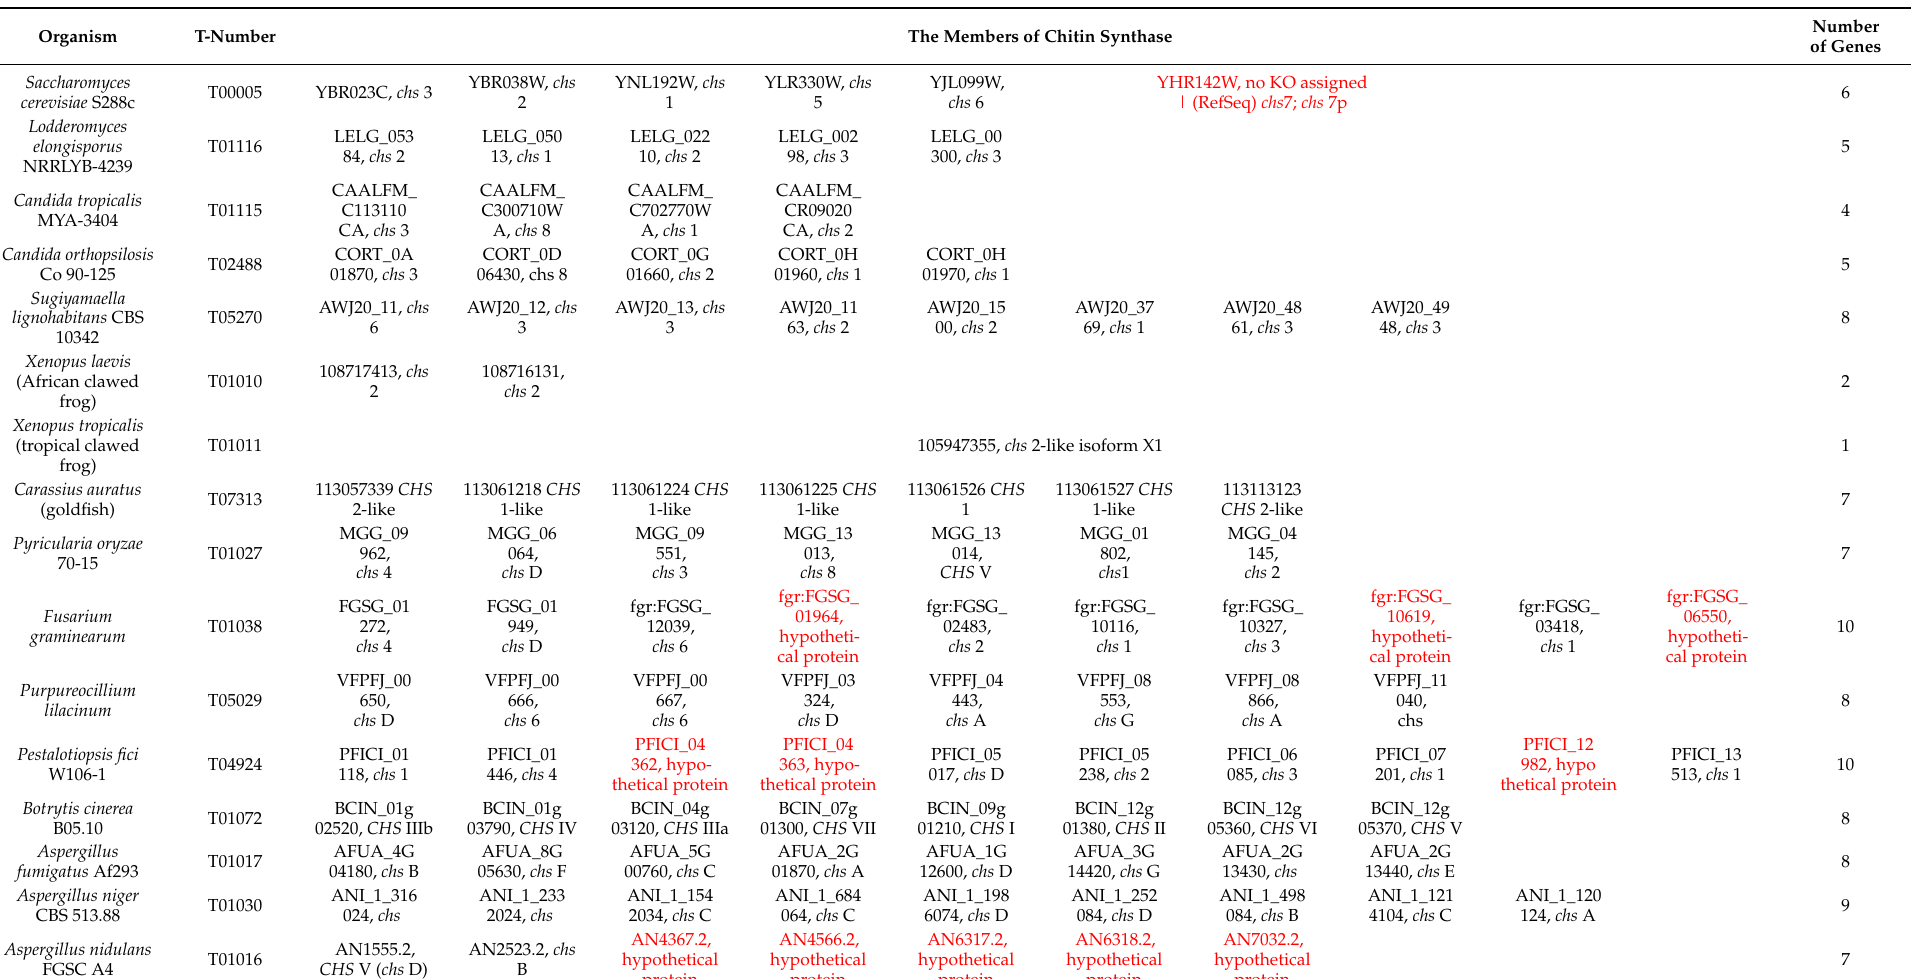
Table 1. The members of the chitin synthase family in a section of diverse fungi. (Completely statistical data are shown in Table S1). chs , represents the gene of chitin synthase; CHS , represents the class of the members of chs family. The genes encoding hypothetical proteins, but mostly like chs , are marked in